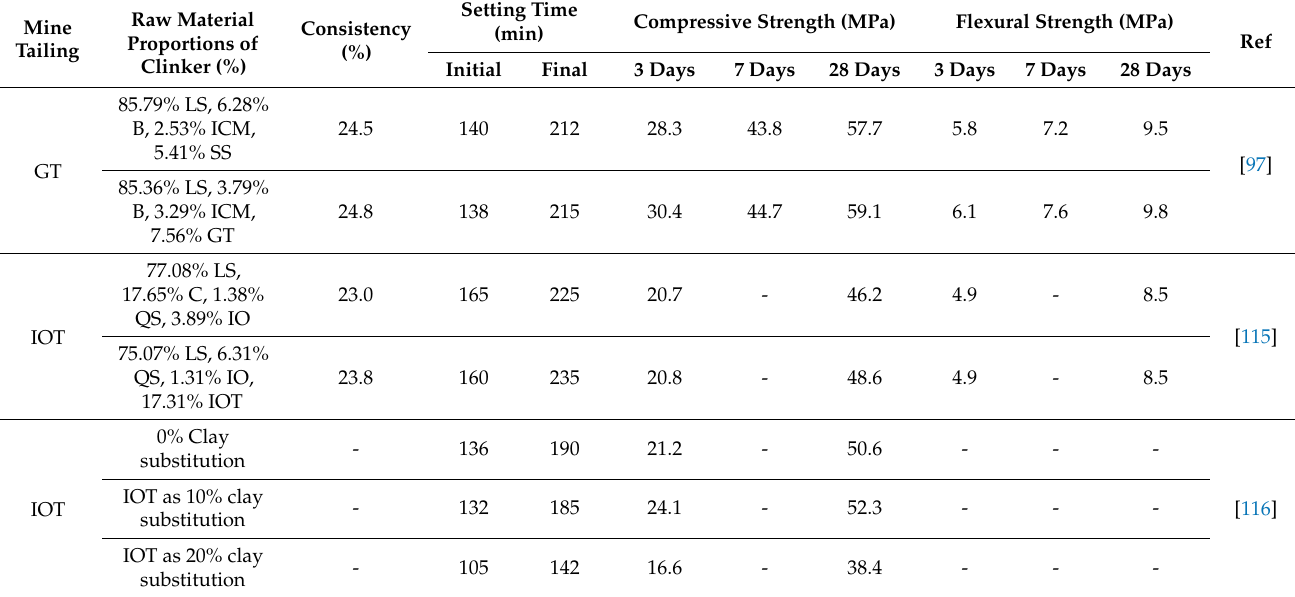
Table 7. Influence of mine tailings on Portland cement